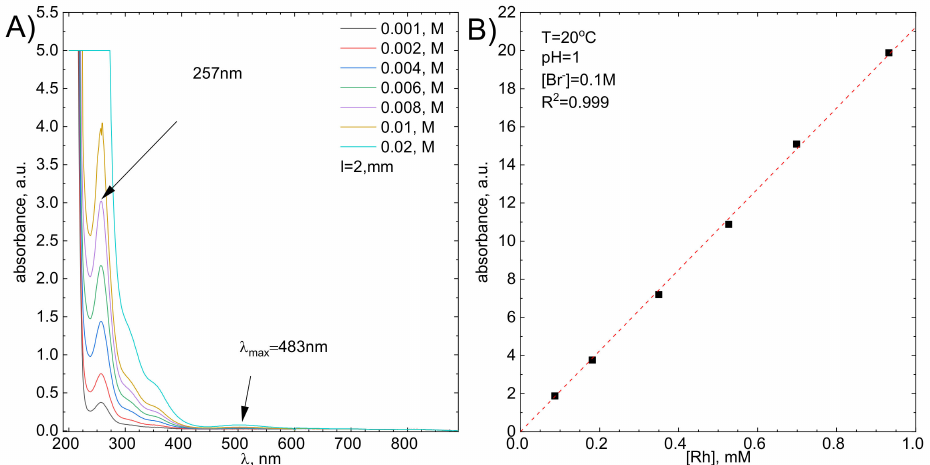
Figure 2. ( A ) UV-Vis spectra of the studied solution as a function of Rh initial concentration, ( B ) Molar absorption coefficient determination using graphical